Question: Based on the figure, does the quantity rise or fall?
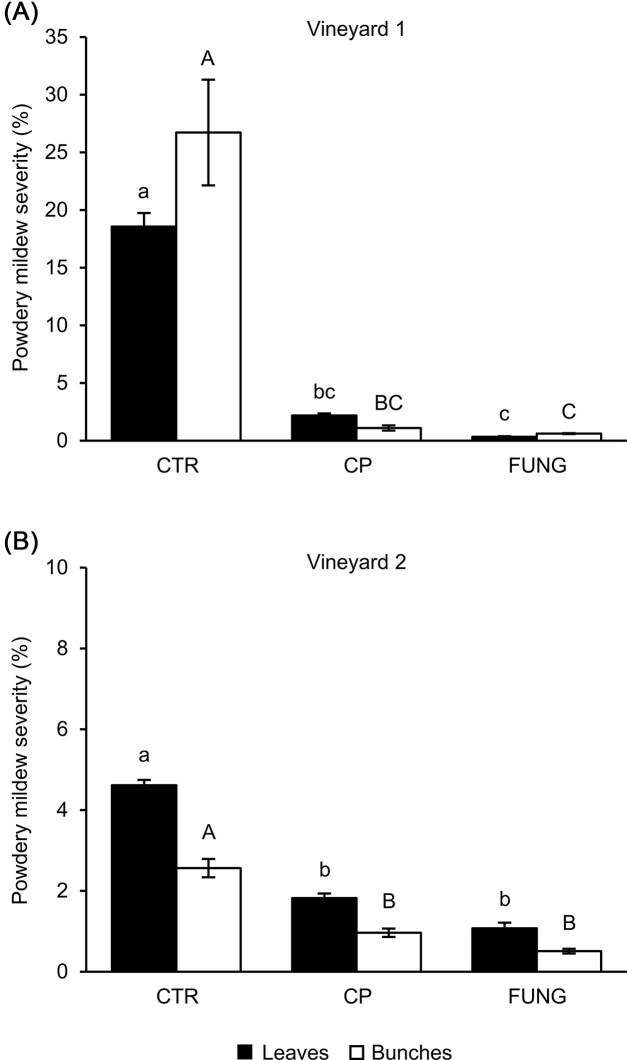
Answer: decreasing